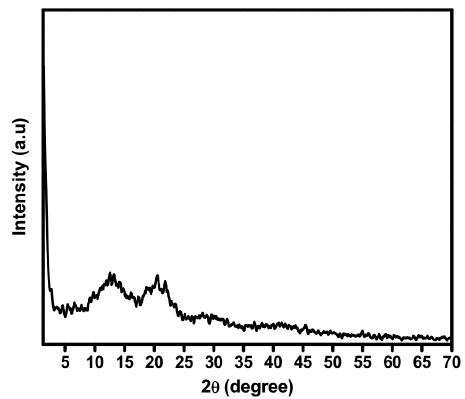
Figure 5. X-Ray diffraction (XRD) pattern of the gel formed from compound 5b .